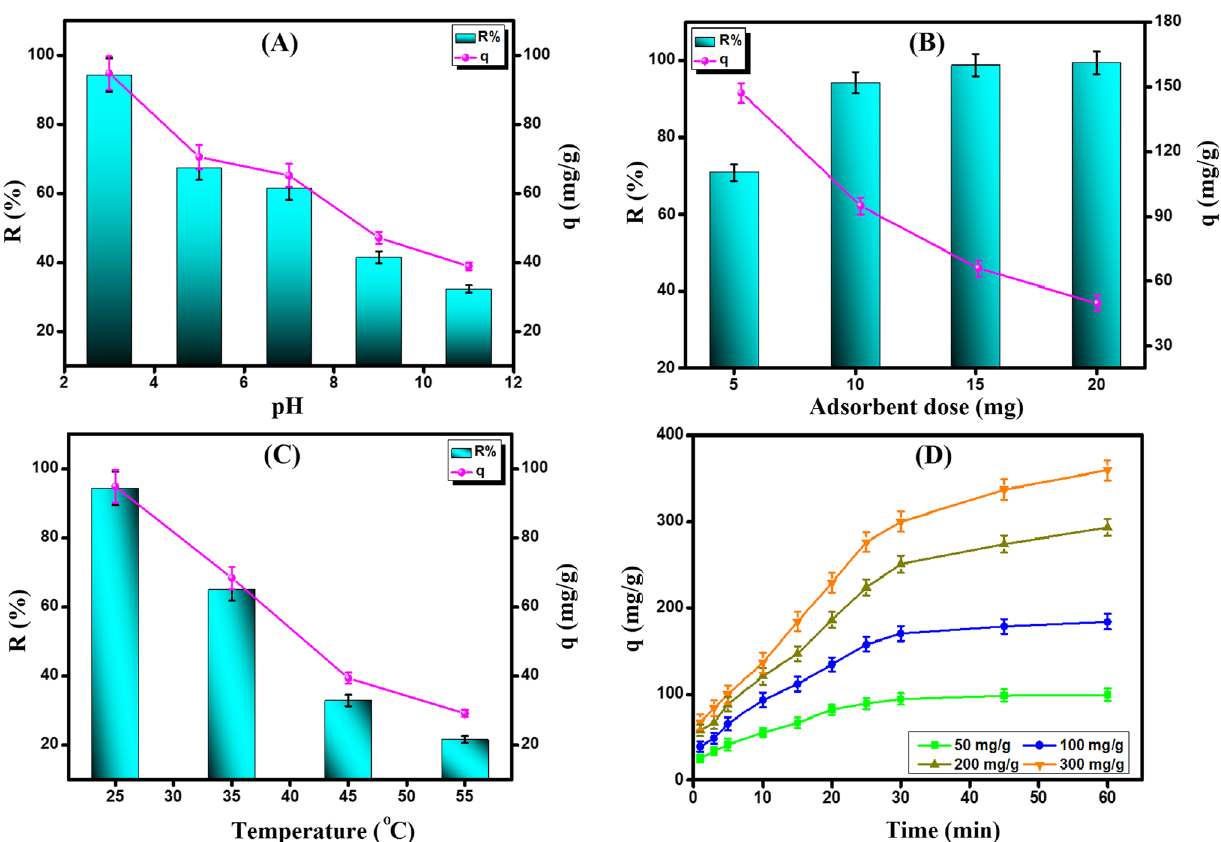
Fig. 4 Optimization of The CR adsorption onto α -kGl-AmCsSB; A pH, B Dosage of α -kGl-AmCsSB, C Temperature, and D Initial concentra- tion of